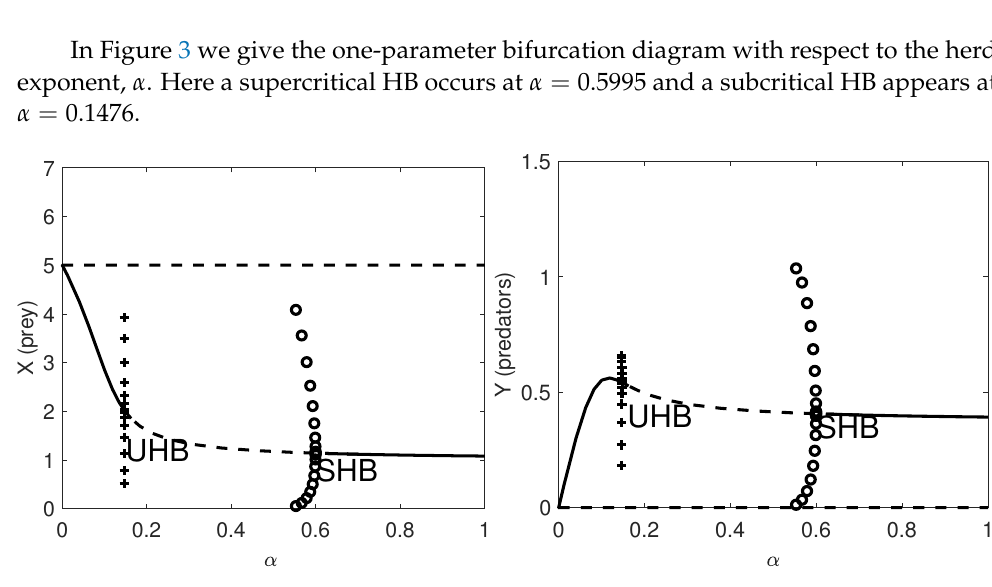
Figure 3. One-parameter bifurcation diagram with respect to α . Left panel : the prey population dynamics. Right panel : the predator population dynamics. Thick lines: stable equilibria; dashed lines: unstable equilibria; SHB: supercritical Hopf bifurcation point where a stable limit cycle arises with maximum amplitude given by the amplitude of the SHB (circles); UHB: subcritical Hopf bifurcation point, where an unstable limit cycle arises with maximum amplitude given by the amplitude of the UHB (pluses); TB: transcritical bifurcation point where the coexistence equilibrium exchanges its stability with the prey-only equilibrium. The remaining parameter values are as in Table